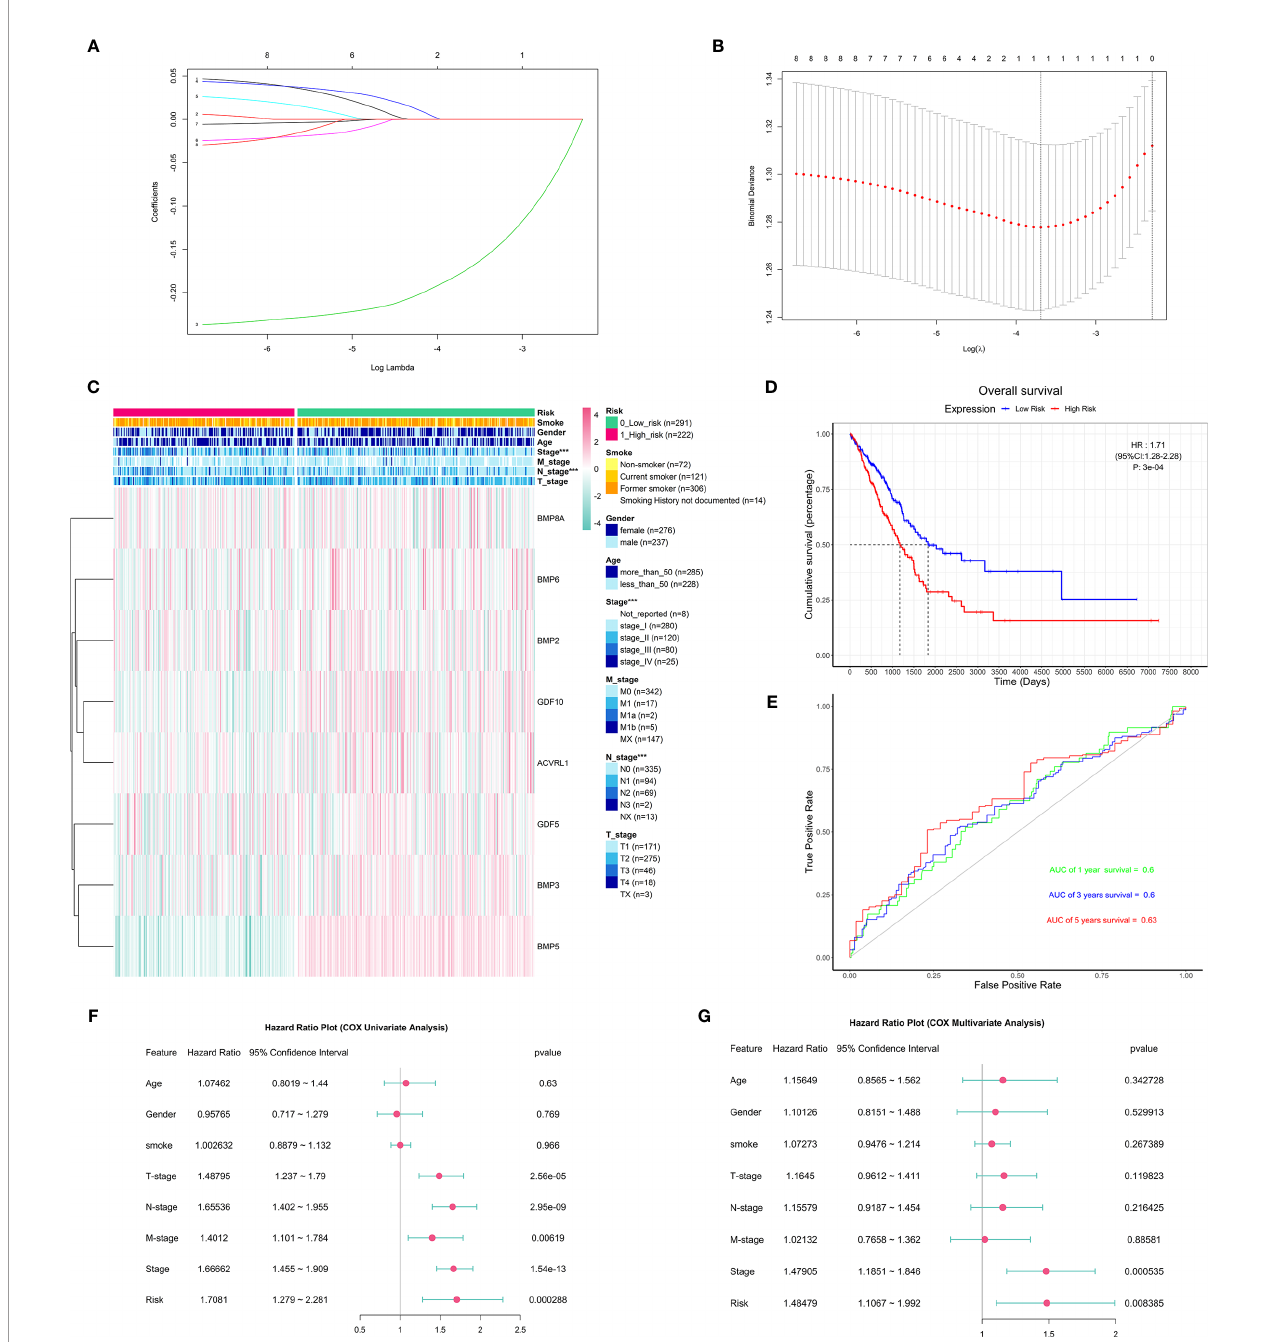
FIGURE 4 | The construction and association of the risk model with clinicopathological features and prognostic value. (A) Distribution of least absolute shrinkage and selection operator (LASSO) coef fi cients for eight differentially expressed BMPs/BMPRs. (B) Partial likelihood deviation of the LASSO coef fi cient distribution. Vertical dashed lines indicate lambda.min (left) and lambda.1se (right). (C) Heatmap of the association between the risk model and clinicopathological features including age, gender, smoking, stage, T-stage, N-stage, and M-stage (***p < 0.001); smoking index information of smokers is not available. (D) The Kaplan – Meier curve of patients with low risk and high risk based on the risk model in TCGA-LUAD (HR: 1.71, 95% CI: 1.28 – 2.28, p : 3e-04). (E) The receiver operating characteristic (ROC) curve for the prognostic value of the risk model (AUC of 1-year survival: 0.6, 3-year survival: 0.6, 5-year survival: 0.63). (F) The forest plot of the univariate Cox proportional hazard model including clinicopathological features and risk. (G) The forest plot of the multivariate Cox proportional hazard model including clinicopathological features (stage: HR = 1.47905, 95% CI = 1.1851 – 1.846, p = 0.000535 < 0.001) and risk (HR: 1.48479, 95% CI: 1.1067 – 1.992, p = 0.008385 <